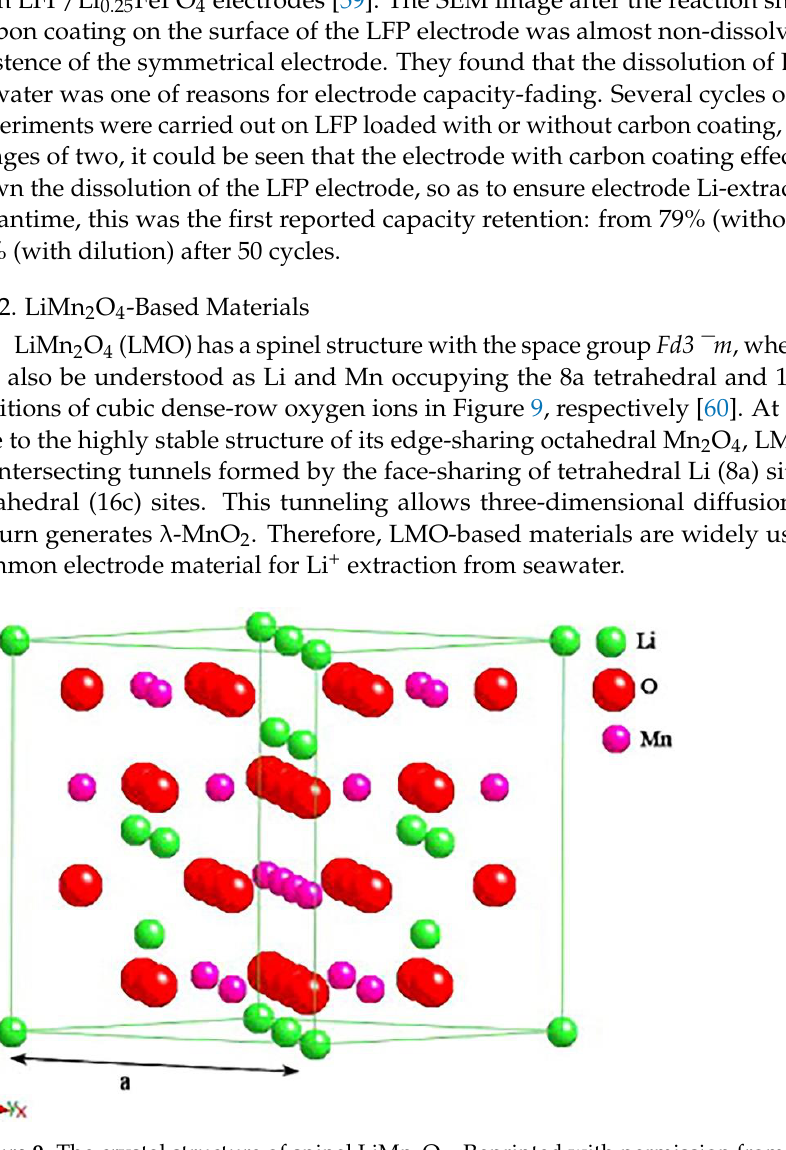
Figure 9. The crystal structure of spinel LiMn 2 O 4 . Reprinted with permission from Ref. [60]. Copy- right 2012 Elsevier.